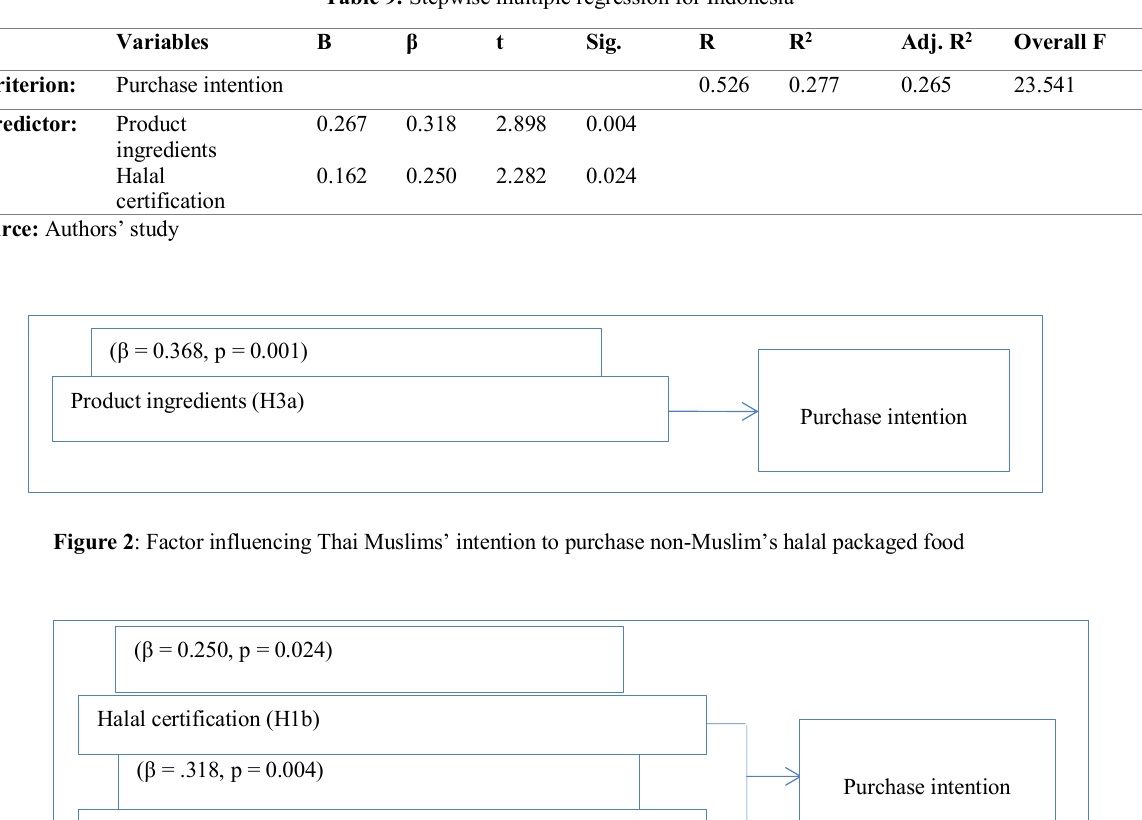
Table 9: Stepwise multiple regression for Indonesia